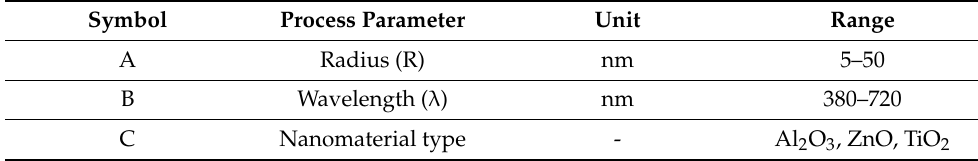
Table 1. The model process parameters and